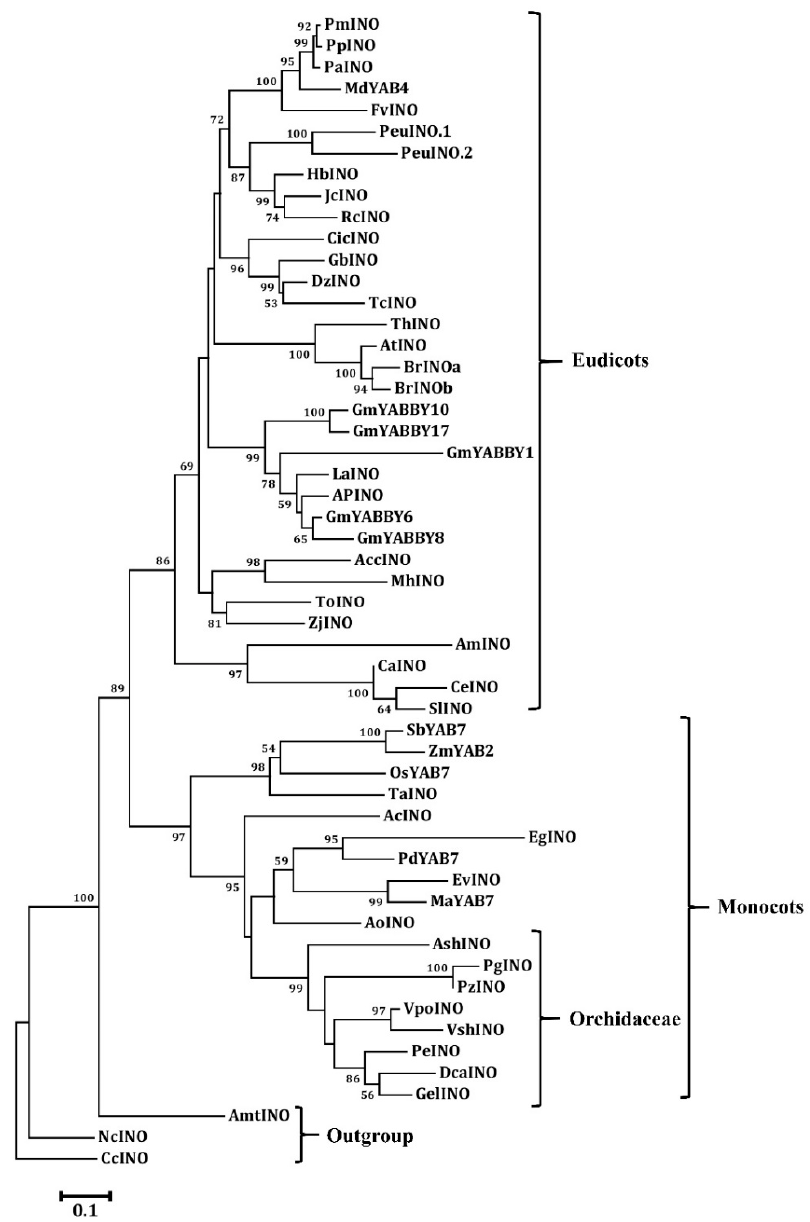
Figure 5. Phylogenetic tree of the INO protein from the angiosperms. The phylogenetic tree was constructed with the neighbor-joining (NJ) method in MEGA 6.0 software. A bootstrap analysis was conducted with 1000 replications. The protein accession numbers for the related proteins are listed in Supplementary Table S1.